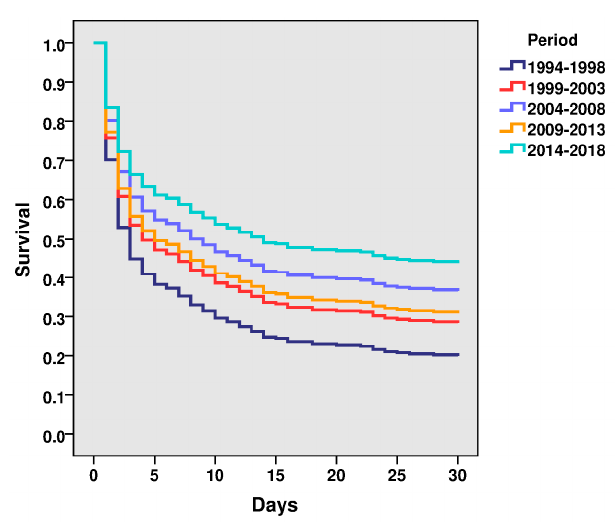
Figure 2. Thirty-day Cox regression multivariate analyses. Table 4. Multivariable Cox regression analyses for ICCU mortality, 30-day case fatality and 1-year all-cause mortality.